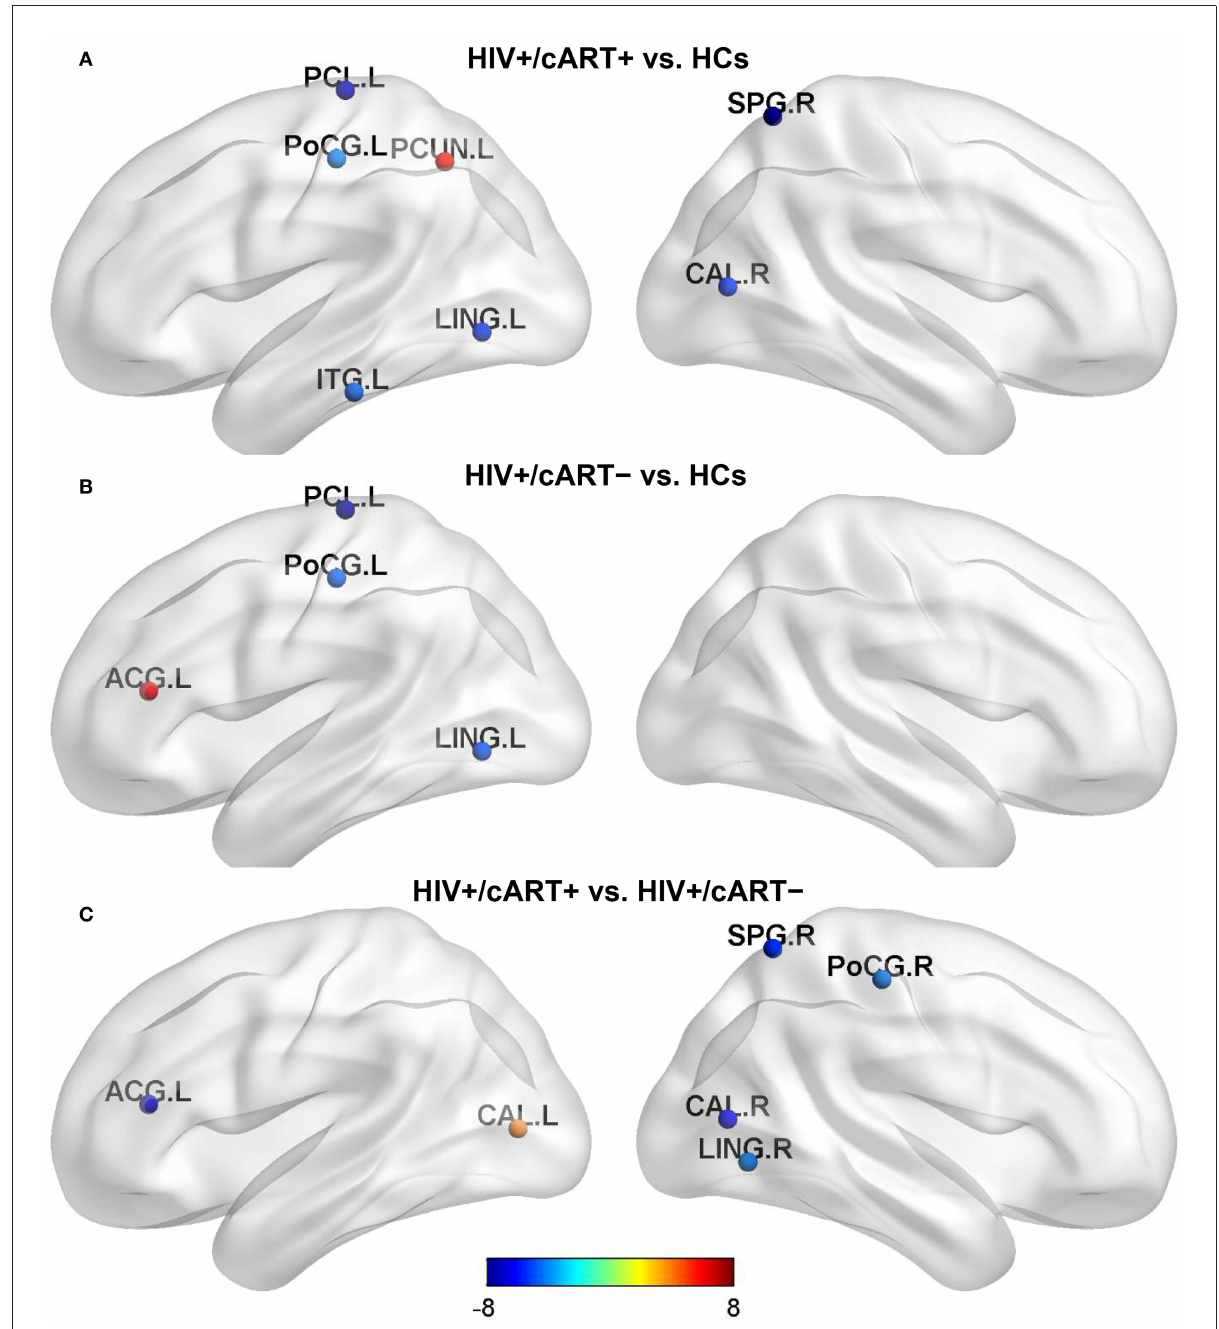
FIGURE2 Between-group results in regional nodal metrics-Bc. The color bar scales represent the t value of Bc difference between groups. Blue (a negative t value) indicates that the former < the latter. Red and yellow (a positive t value) indicate that the former > the latter. Compared with HCs, Bc in the parietal lobe and occipital lobe decreased both in HIV + /cART + (A) and HIV + /cART– group (B) , and the brain area of decreased Bc in HIV + /cART + group was more extensive (C) . L, left; R, right; ITG, inferior temporal gyrus; LING, lingual gyrus; PCL, paracentral lobule; CAL, pericalcarine cortex; PoCG, postcentral gyrus; PCUN, precuneus; SPG, superior parietal gyrus; ACG, anterior cingulate